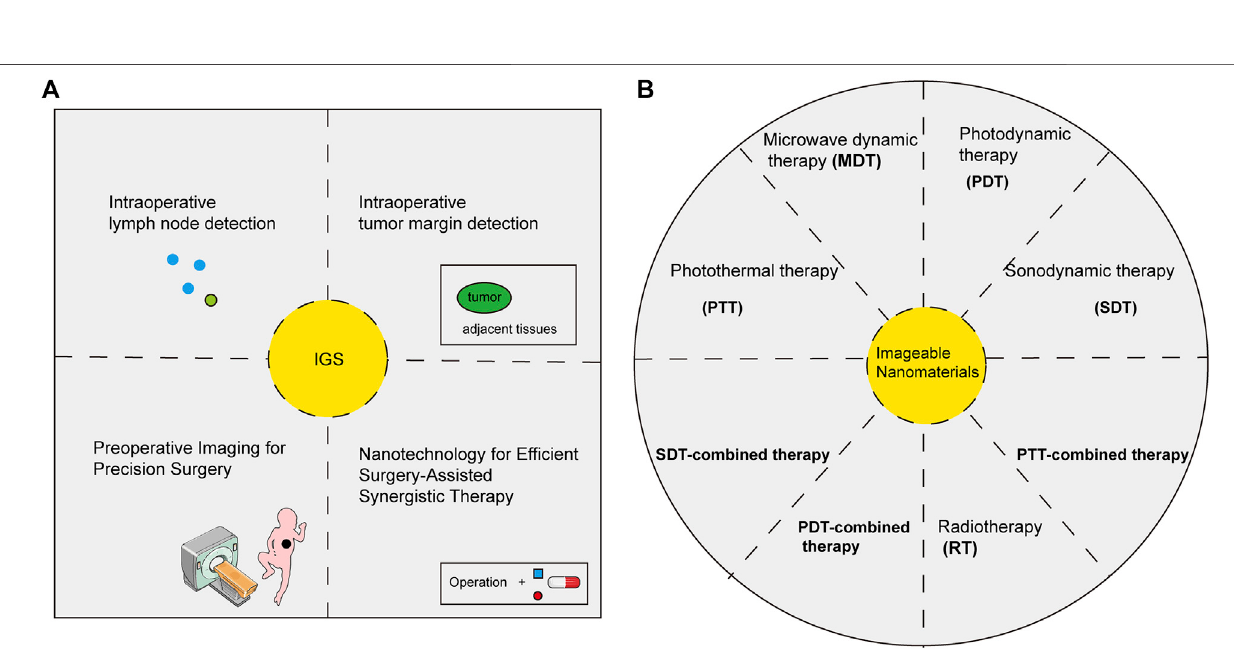
Frontiers in Bioengineering and Biotechnology |